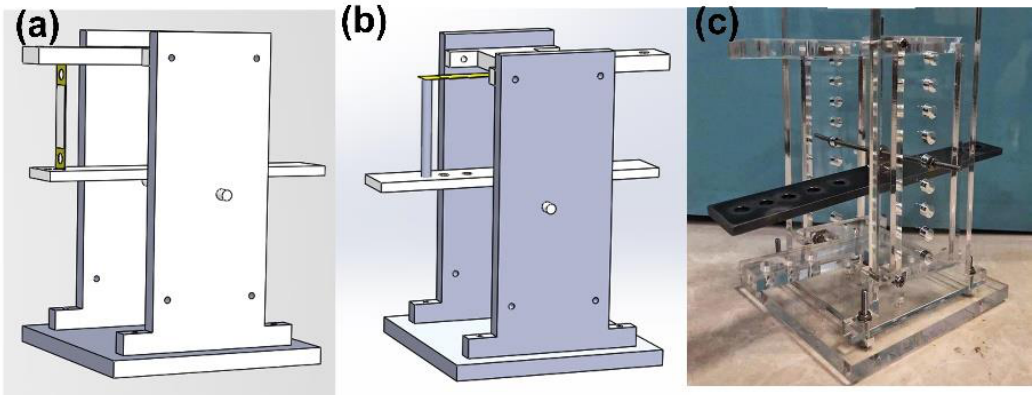
Figure 4. The experimental fixture for validating ADB and BCB approaches ” ( a ) scheme for ADB, ( b ) scheme for BCB, and ( c ) the photo of the fabricated fixture.